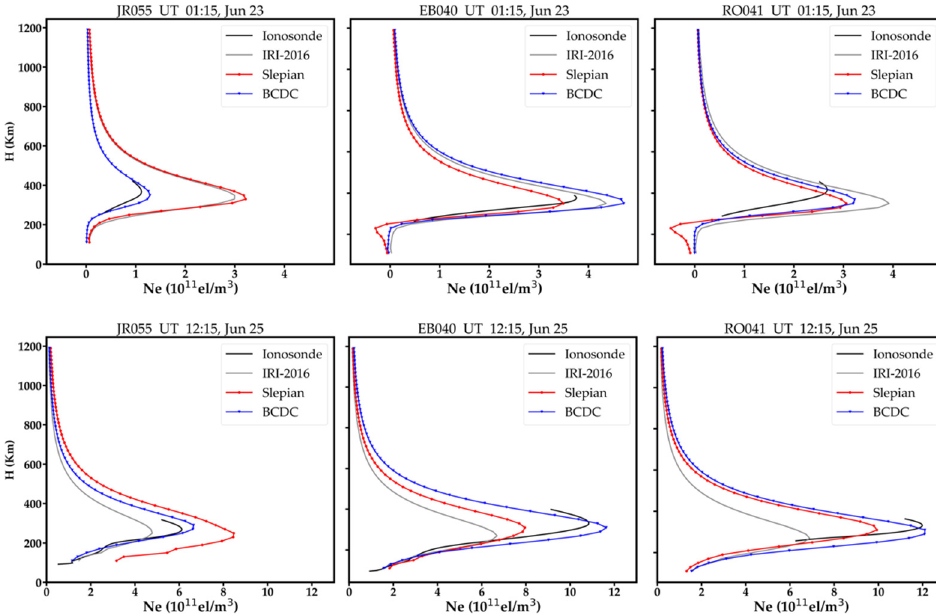
Figure 8. Vertical profiles obtained by the BCDC method, the Slepian method and the IRI − 2016 model against the those observed at JR055, EB040 and RO041 stations during the geomagnetic disturbed time.